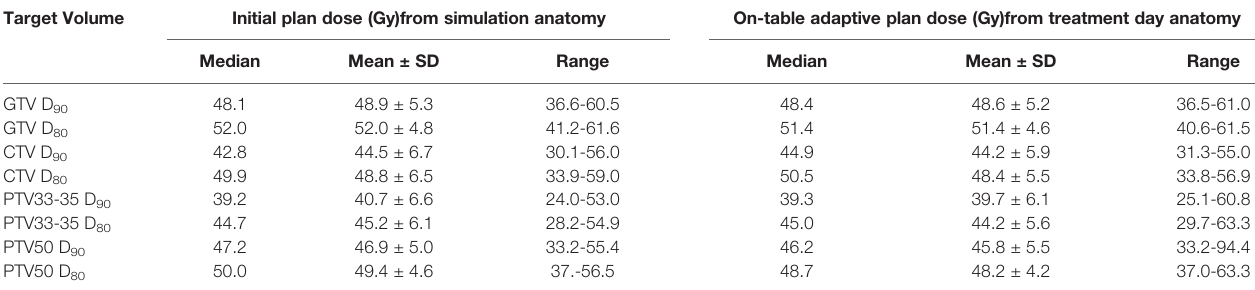
TABLE 2 | Target volume coverage on the initial plan versus the on-table adaptive plans. Target Volume Initial plan dose (Gy)from simulation anatomy On-table adaptive plan dose (Gy)from treatment day anatomy